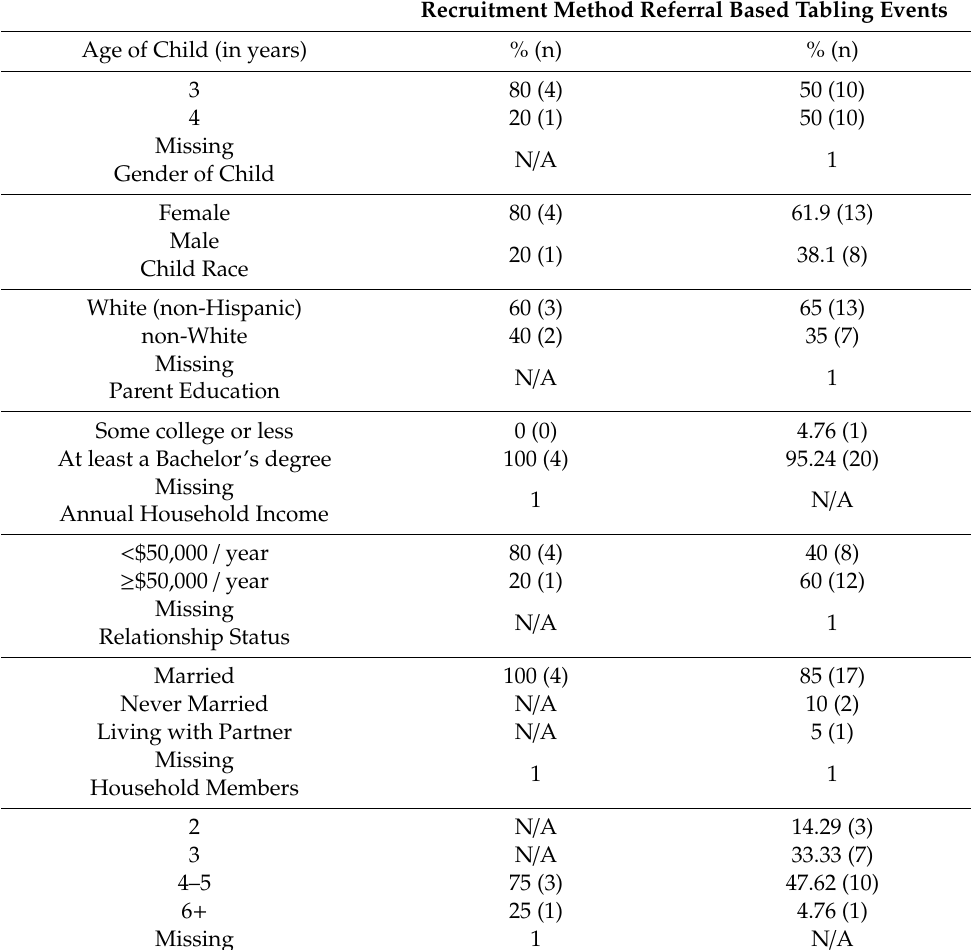
Table 1. Descriptive statistics for all participants, by recruitment